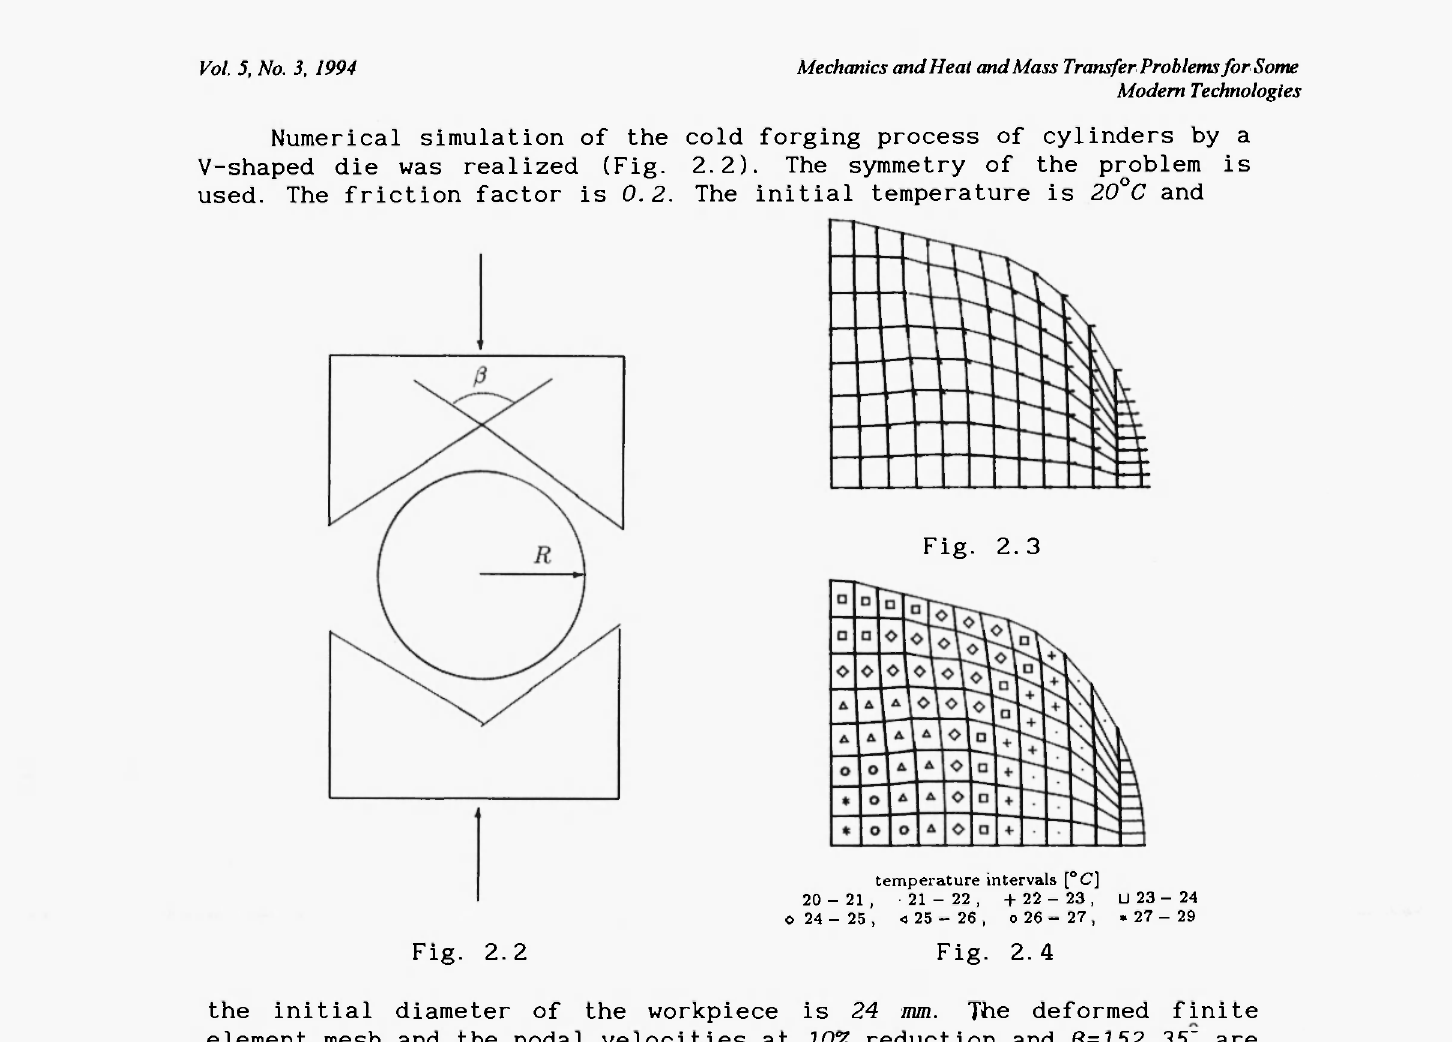
the initial diameter of the workpiece is 24 mm. The deformed finite element mesh and the nodal velocities at 10 % reduction and ß=152. 35 are shown in Fig. 2. 3. Fig. 2. 4 shows the corresponding temperature field. Fig. 2.5 shows the effective strain rate field at the same reduction. Calculations at different values of β were realized in